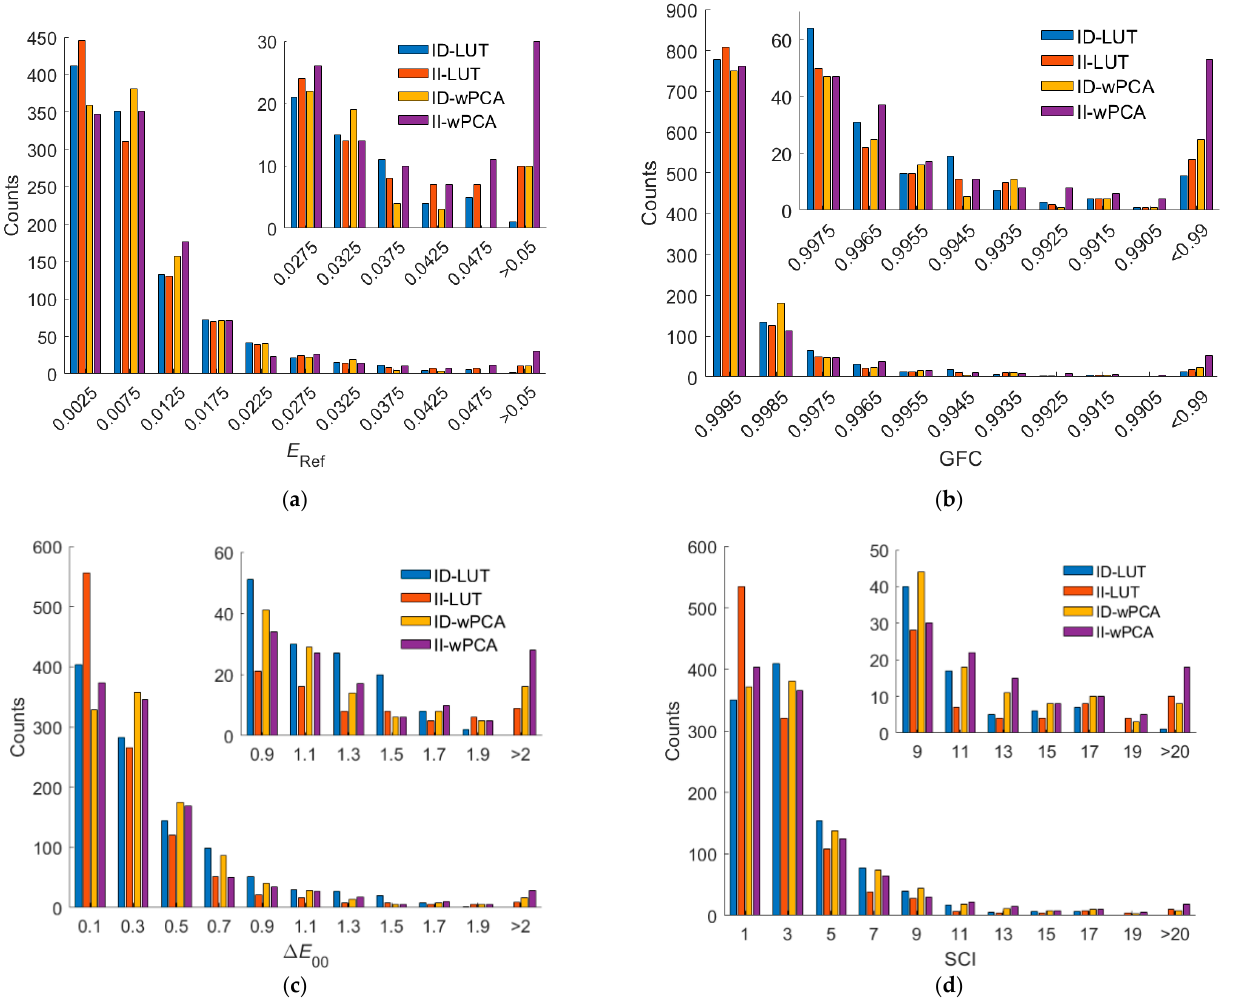
Figure 12. ( a ) E Ref , ( b ) GFC, ( c ) Δ E 00 , and ( d ) SCI histograms for the 1066 test samples. The camera is the RGBF camera. The spectrum reconstruction methods are shown in figures. The insets show enlarged parts.